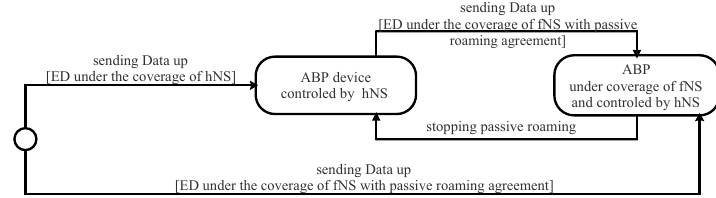
Figure 10. States of an ABP